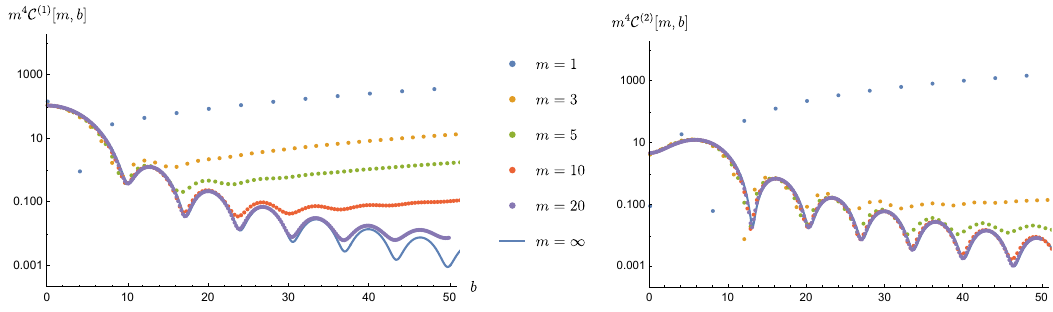
Figure 3. Action of the C ( i ) functionals in (2.20) for i = 1 , 2 respectively, on various heavy states with m ≥ M in units where M = 1 . Individual points, representing different spins J , are lined up with constant impact parameter b = 2 J in order to highlight the regularity as m → ∞ and m J → ∞ . This helps confirm positivity on all heavy states. The blue outliers (at J = 2 and J = 0 , 4 respectively) are caused by single zeros slightly below threshold m = M